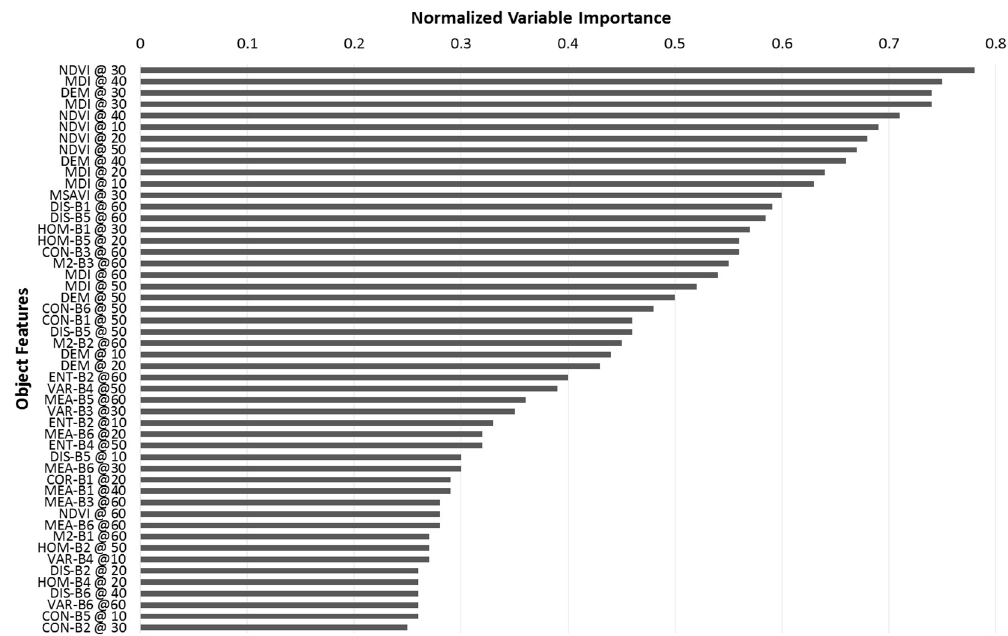
Figure 6. Rankings of the 50 most important object features in the RF model. Variables with high Normalized Variable Importance values, such as NDVI and MDI, are deemed highly important in the classification. The scales are also listed after the “@” symbol. HOM = homogeneity, CON = contrast, M2 = second moment, ENT = entropy, VAR = variance, MEA = mean, DIS = dissimilarity, COR = correlation, DEM = Digital Elevation Model. B2 to B7 are Landsat OLI bands 2 to 7. Scalewise, medium coarse image segmentation scales (30 and 40) dominated the top 5. Finer